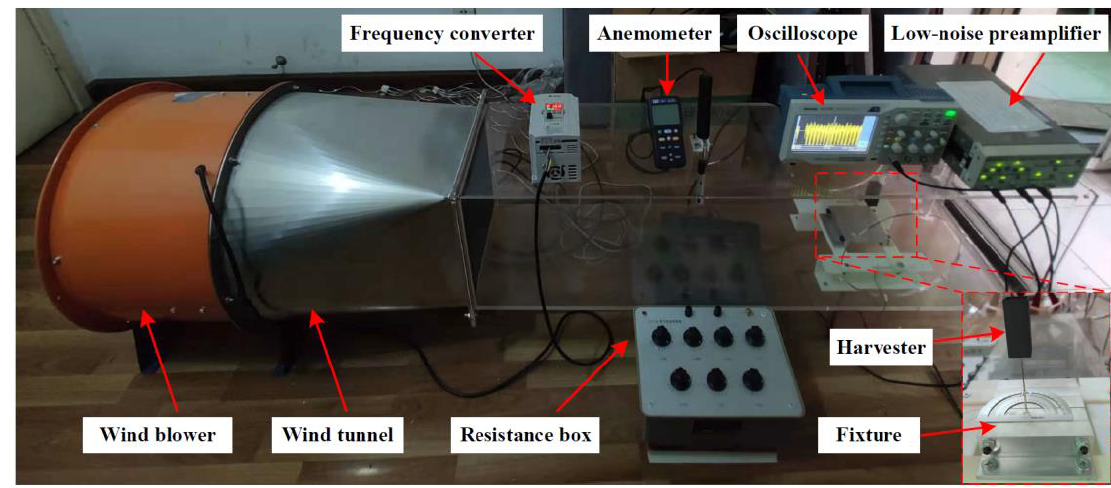
Figure 2. Wind tunnel experimental system.